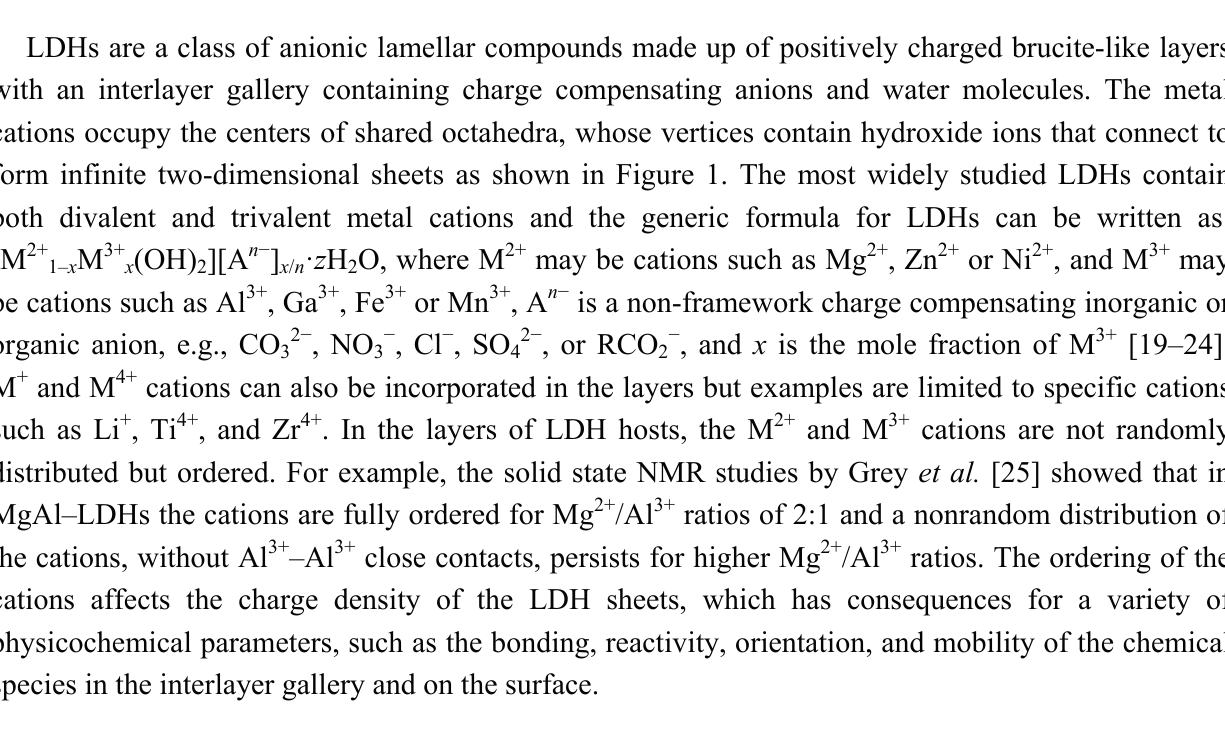
Figure 1. Schematic representation of the structure of layered double hydroxides